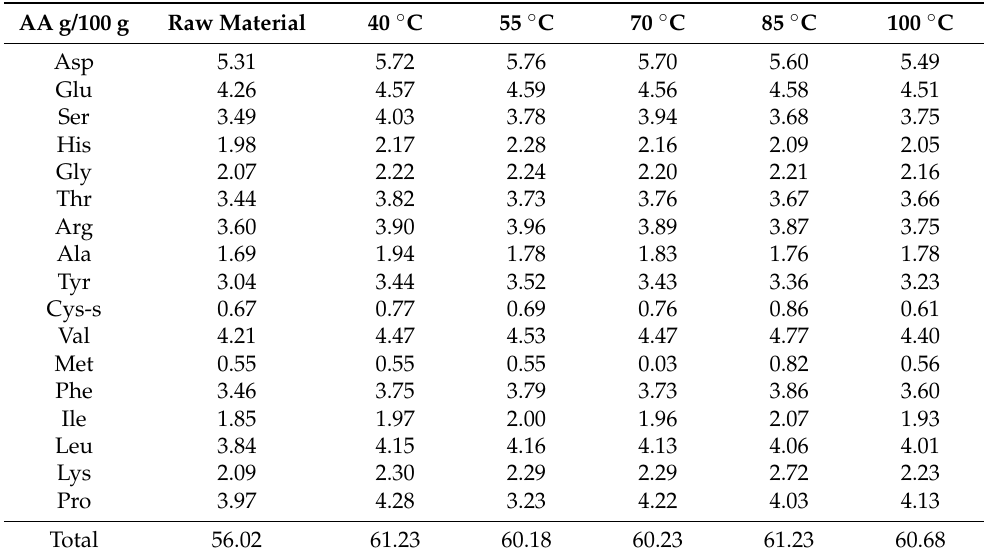
Table 2. Amino acid (AA) compositions (g/100 g) of the EBN insoluble fraction. AA g/100